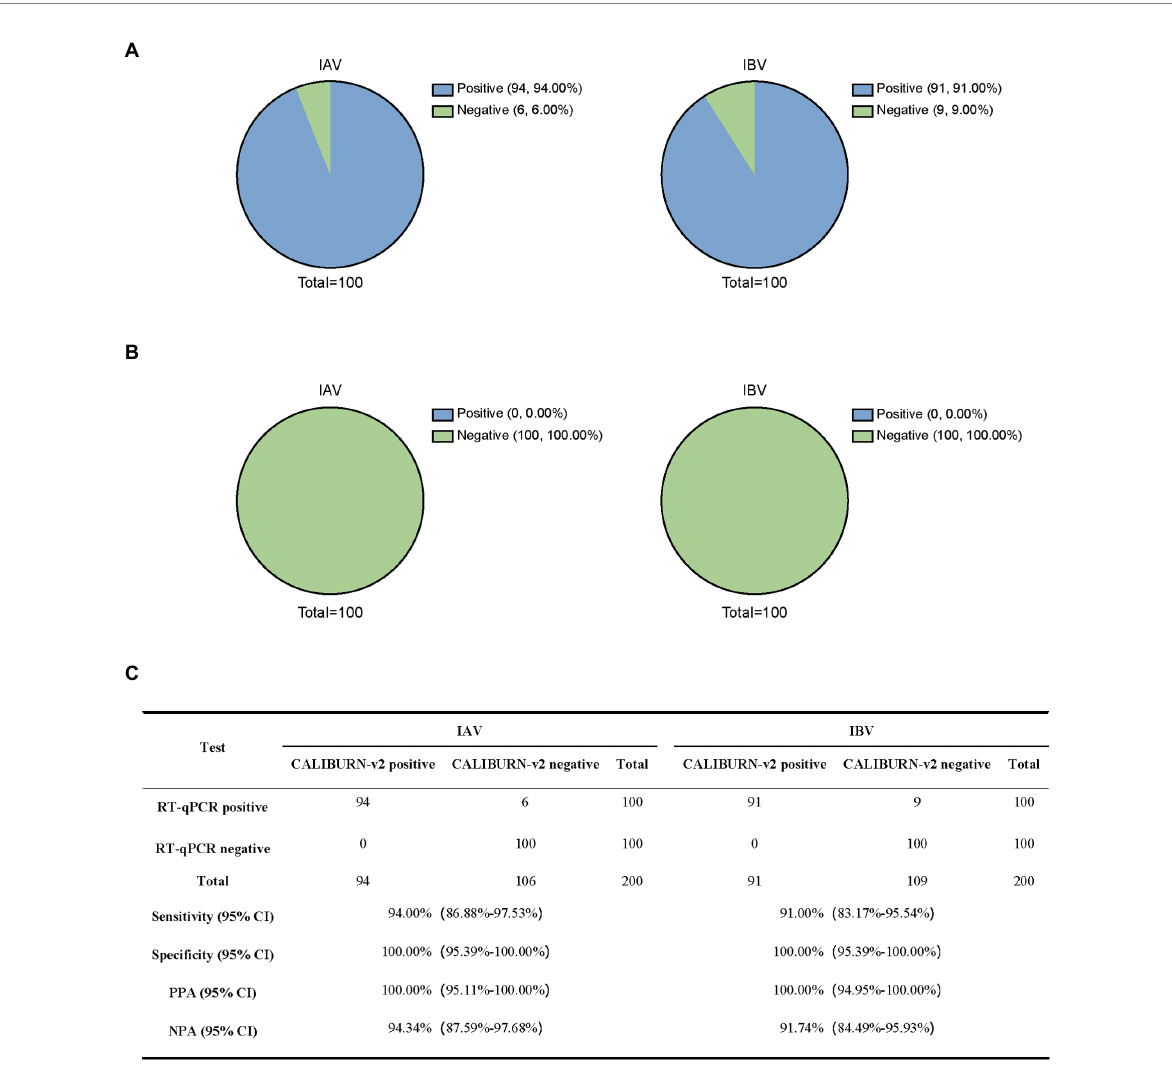
and 91.00% sensitivity to IAV and IBV, respectively, (Figure 5A) and 100% specificity for both pathogens (Figure 5B). These results corresponded to 100% PPA for both pathogens and NPA values of 94.34% for IAV and 91.74% for IBV, respectively (Figure